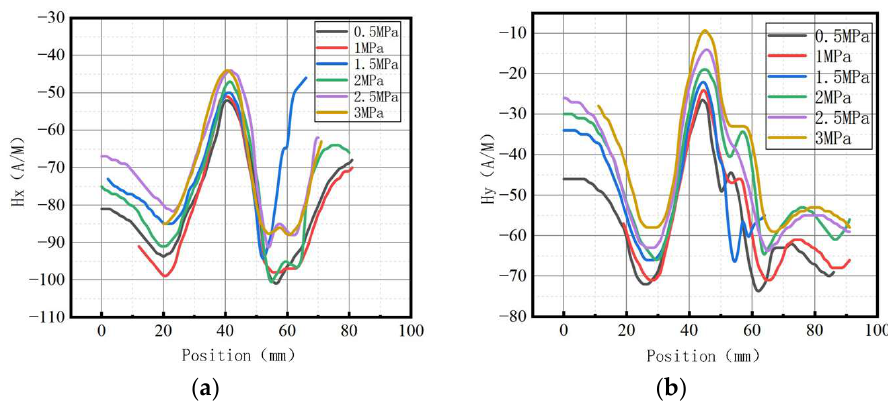
Figure 30. Magnetic signal changes at weld crack with internal pressures. ( a ) Axial component of weak magnetic signal; ( b ) radial component of weak magnetic signal.